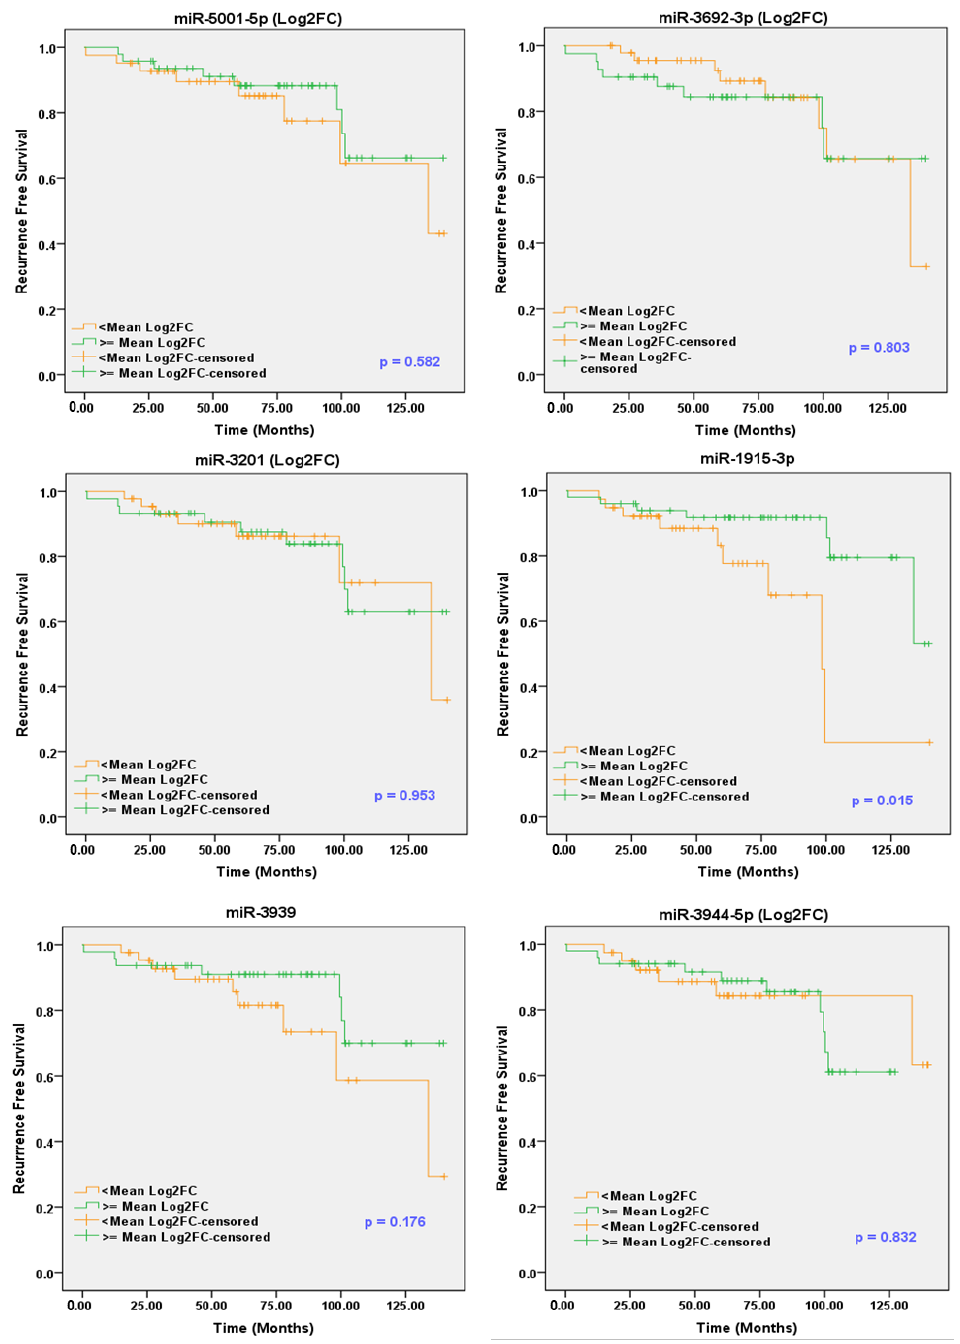
Figure 3. Recurrence-free survival analysis for PCa patients expressing high and low levels of sEV-associated miR-1915-3p, miR-3201, miR-3939, miR-3944-5p, miR-miR-3692-3p and miR-5001-5p in NIH cohort. Kaplan – Meier analysis showing that PCa patients had better recurrence-free survival with sEVs enrichment of miR-1915-3p. The p -value was calculated by the log-rank test of the Kaplan – Meier curve.